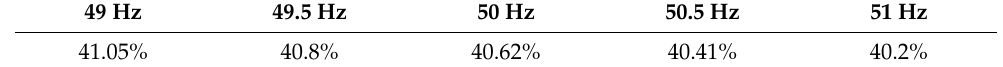
Table 3. The THD of the load current i L .